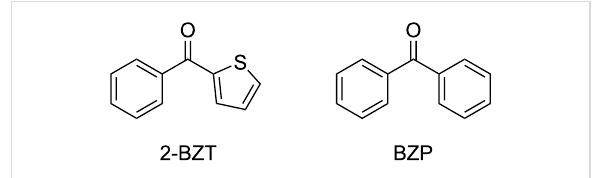
Figure 1: Chemical structure of the photosensitizing chromophores benzophenone (BZP) and 2-benzoylthiophene (BZT).